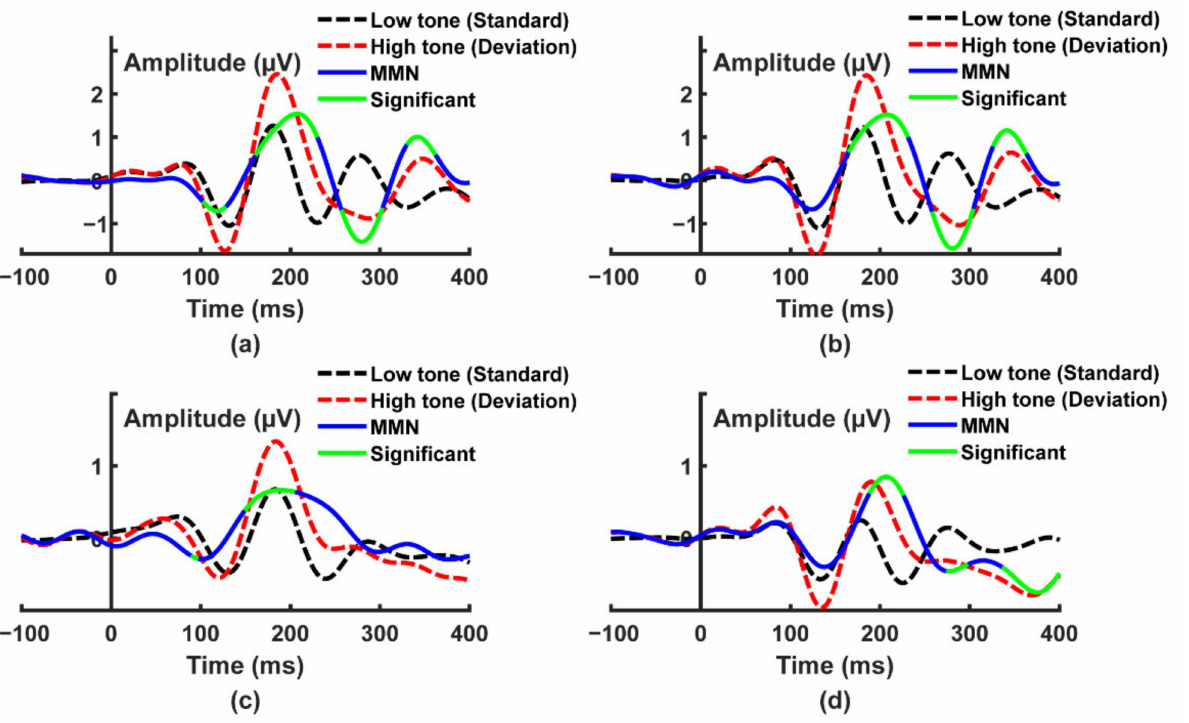
Figure 8. The averaged event related potential (ERP) curves of Neuroscan with low tone and high tone stimulation. ( a ) Fp1; ( b ) Fp2; ( c ) F7; and ( d )